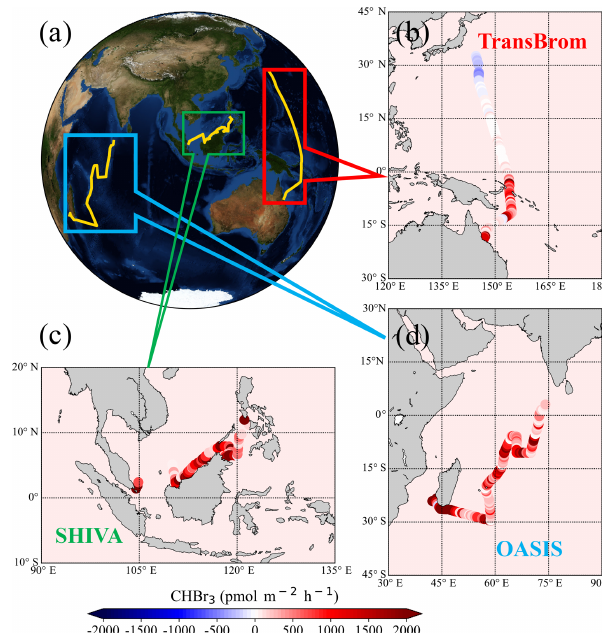
Figure 1. Cruise tracks of the three campaigns in the Indian Ocean and western Pacific (a) and CHBr 3 emissions (b, c, d) used in the model simulation. Global background emissions (100pmolm − 2 h − 1 ) and observed emissions along the tracks of the three research cruises TransBrom (b) , SHIVA (c) , and OASIS (d)